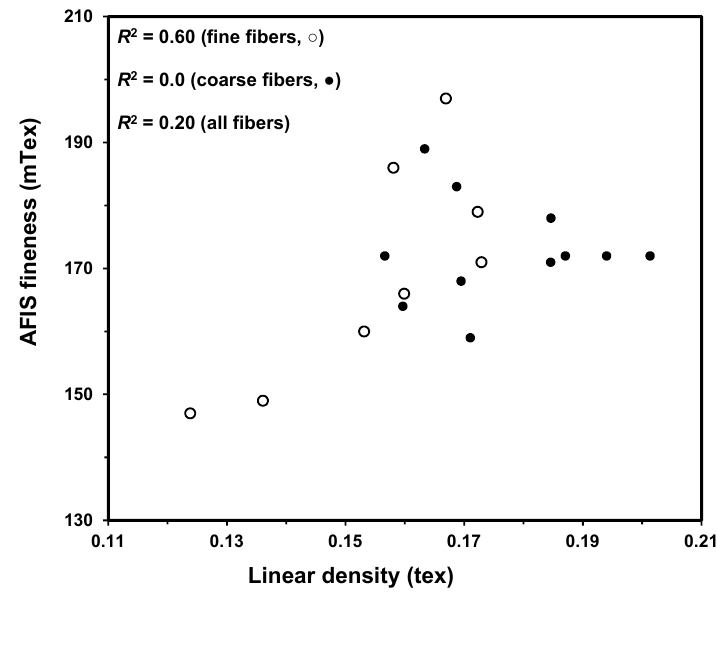
Figure 8. Comparison of Advanced Fiber Information System (AFIS) fineness vs. linear density among fine ( ○ ) and coarse ( ● )